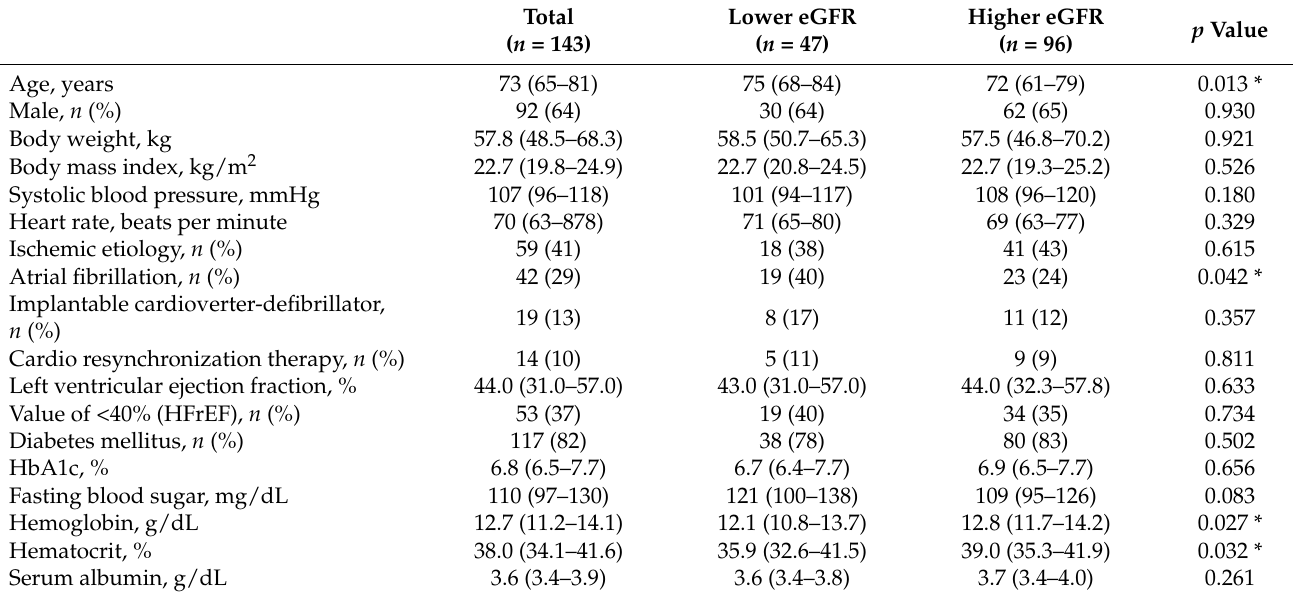
Table A1. Baseline characteristics of patients stratified by